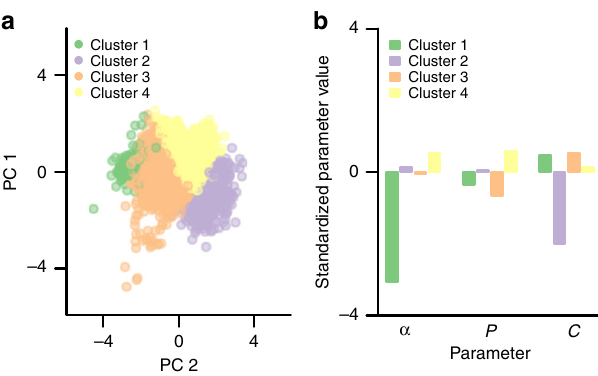
Fig. 5 Experimental manipulation of social reward rates (Study 3). The estimated effect of social reward rate condition on posting latencies in the online experiment ( n = 176 independent individuals, see Supplementary Fig. 5 for a design overview). Results are presented as means ( fi xed effects regression estimates) ±1 SE of the regression estimates from from mixed- effects regression.